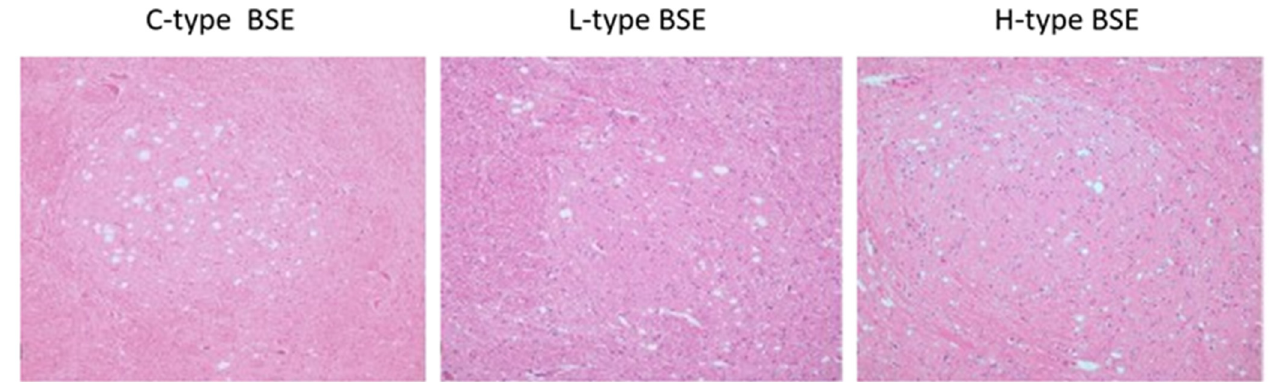
Figure 3. Hematoxylin and eosin (H & E)-stained sections of the solitary tract nucleus of classical and atypical BSE cases. Reprinted from Ref.